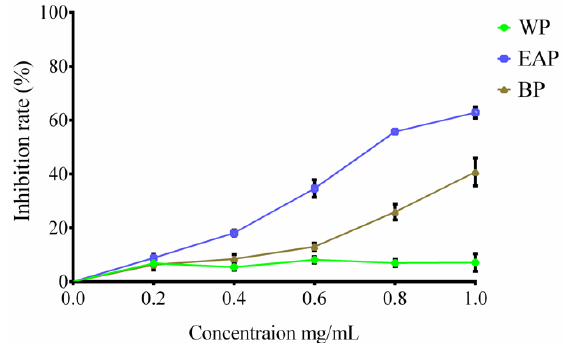
ff ect of three phases on Hela cells treated for 48 Figure 3. The inhibition effect of three phases on Hela cells treated for 48 h. Figure 3. The inhibition e